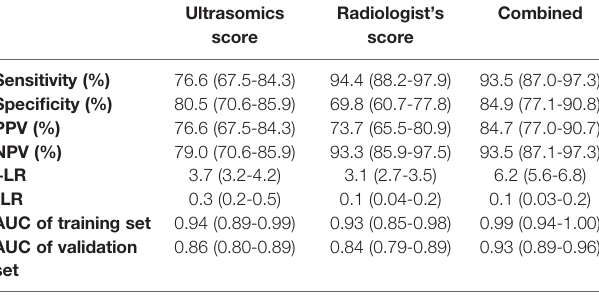
Data in parentheses are 95% con fi dence interval. PPV, positive predictive value; NPV, negativepredictive value;+LR,positivelikelihoodratio; -LR, negativelikelihood ratio;AUC, area under the